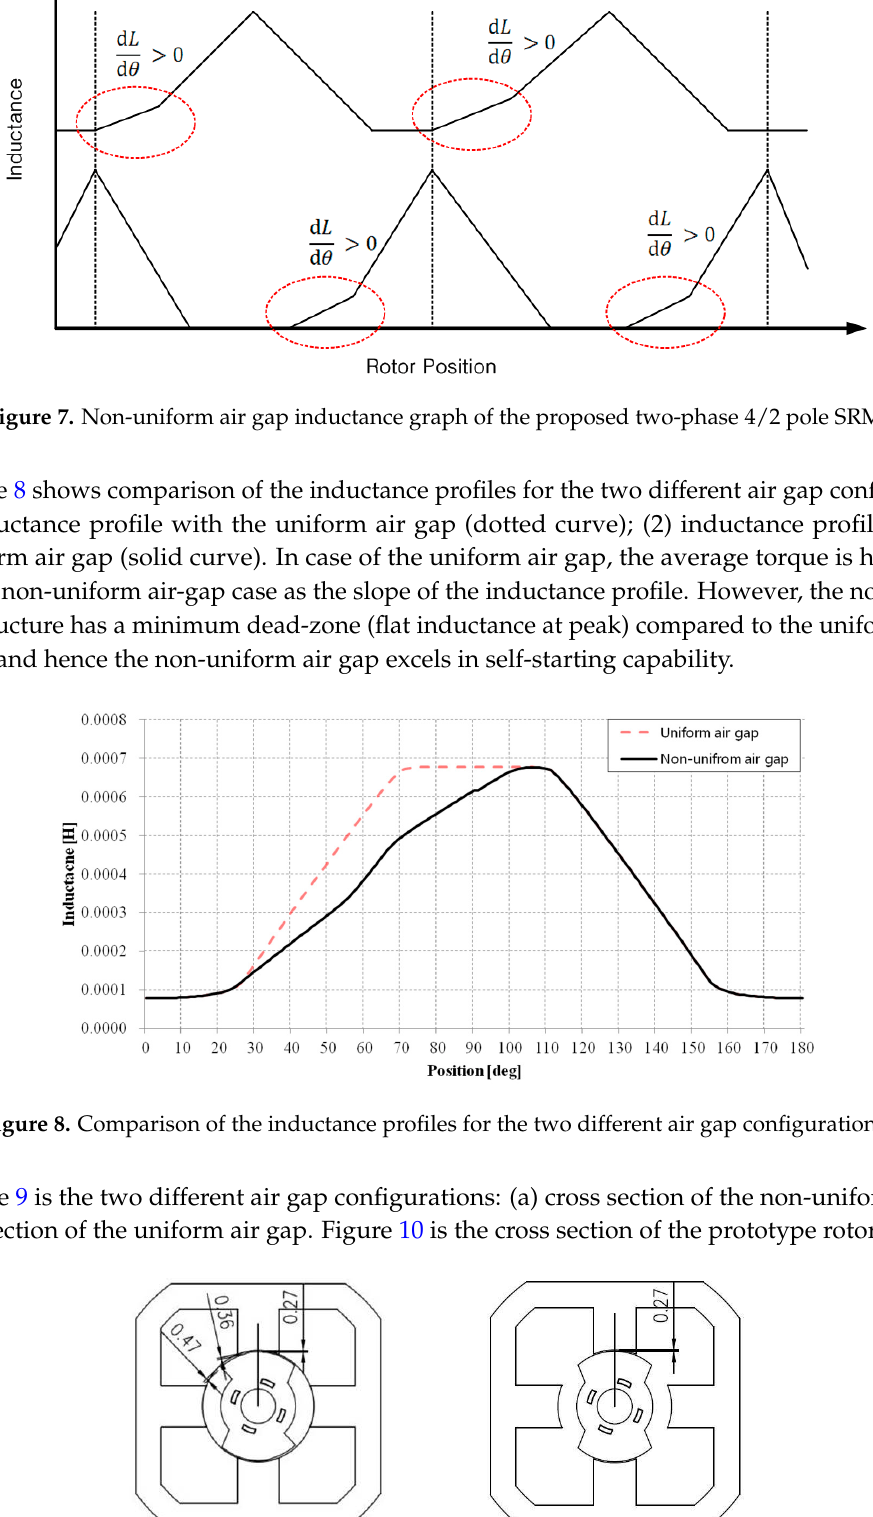
Figure 9. Cross section of the two different air gap. ( a ) Cross section with the non ‐ uniform air gap; ( b ) Cross section with the uniform air gap.